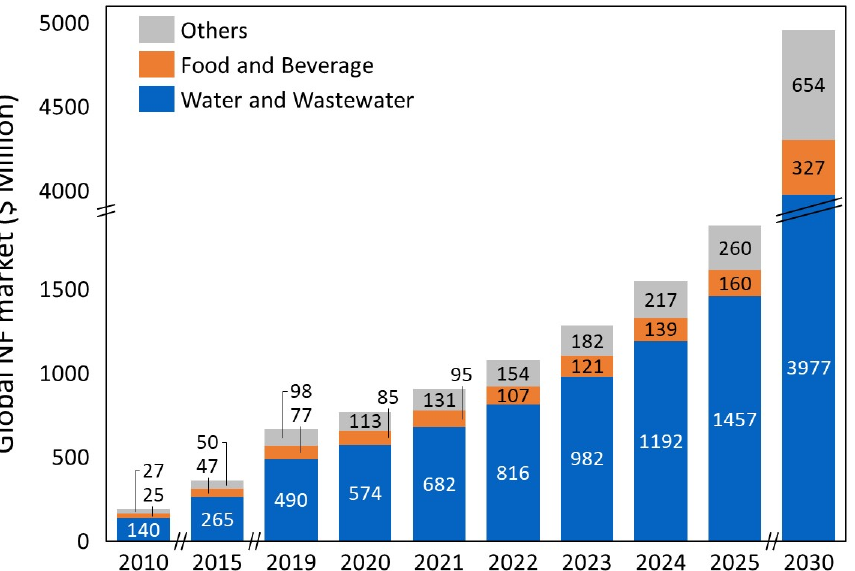
Figure 1. Global annual NF market per application in $ million, including the projected growth